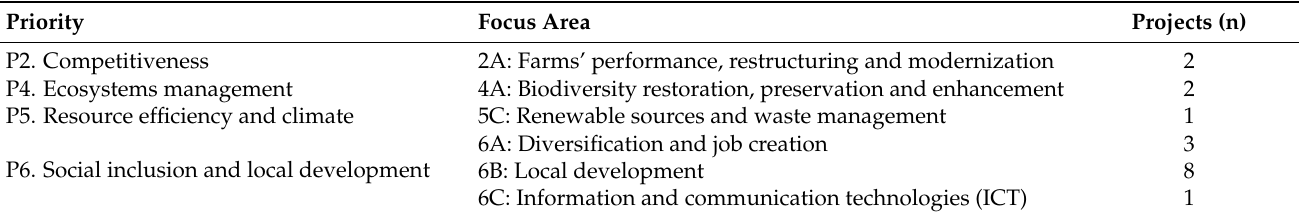
Table 1. Projects implemented under the European Network for Rural Development.